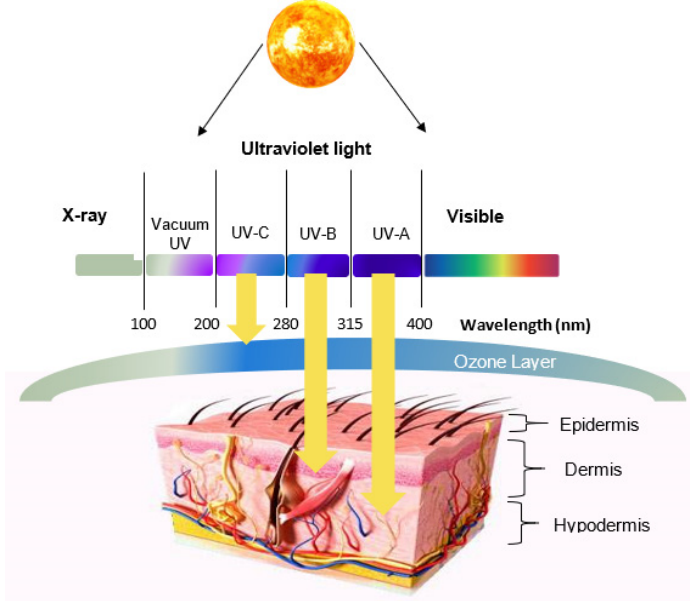
Figure 1. Cross-sectional view of human skin with the ultraviolet radiation (UVR) wavelength- dependent penetration of the skin.